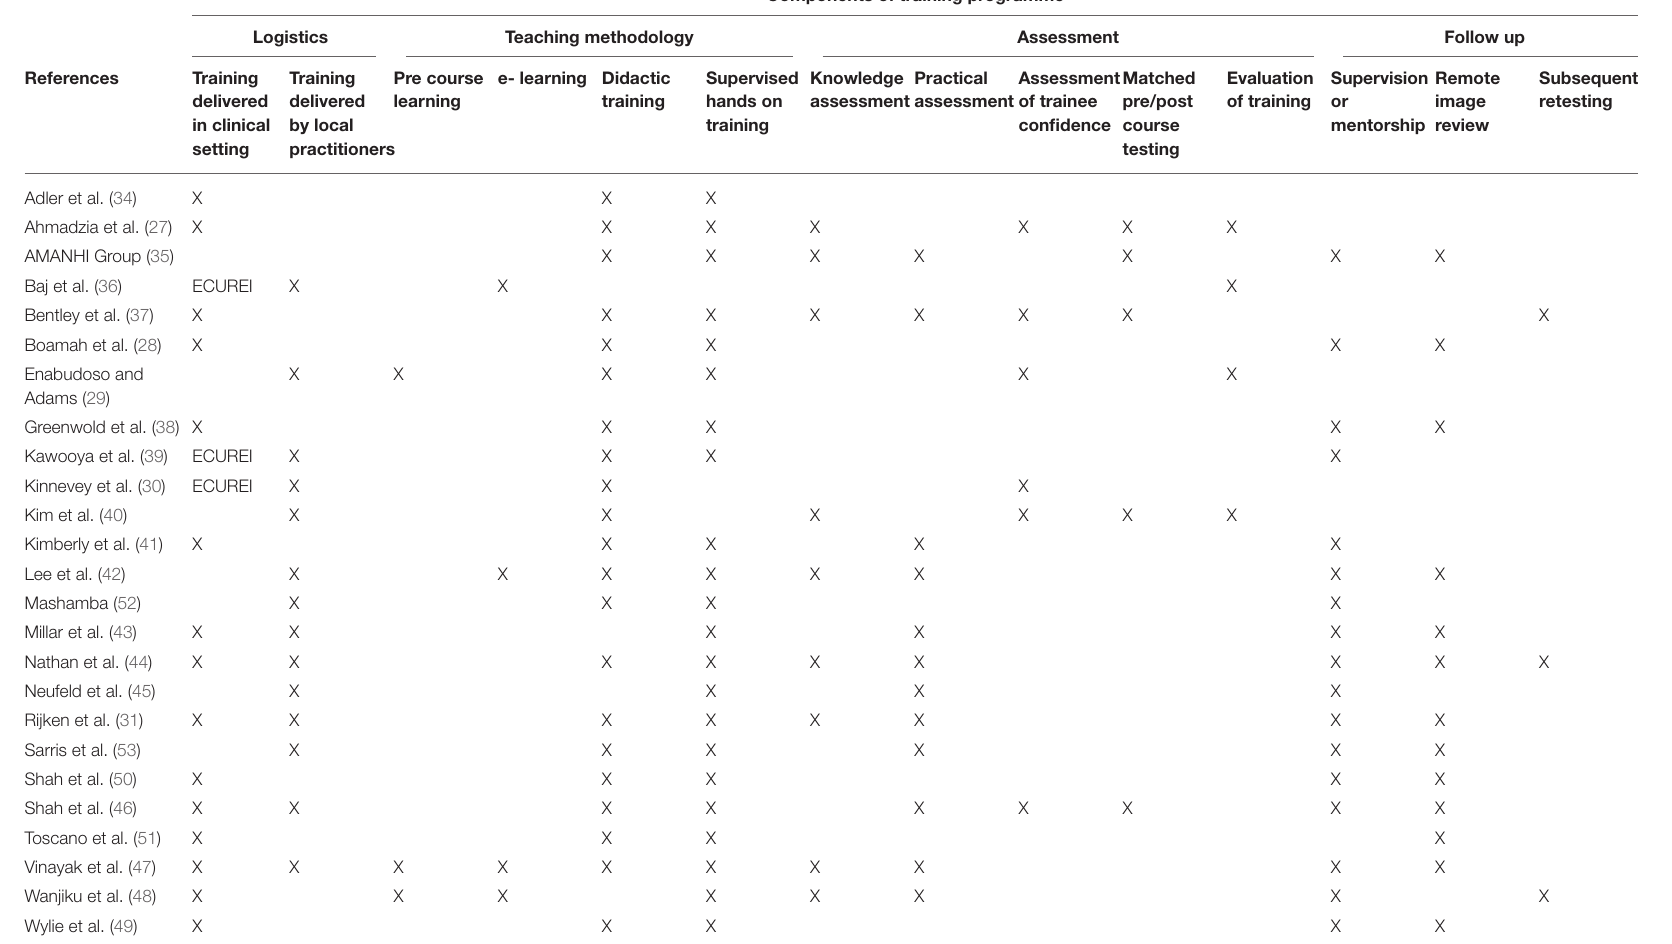
TABLE 2 | Specific components of training programmes (presented alphabetically by first